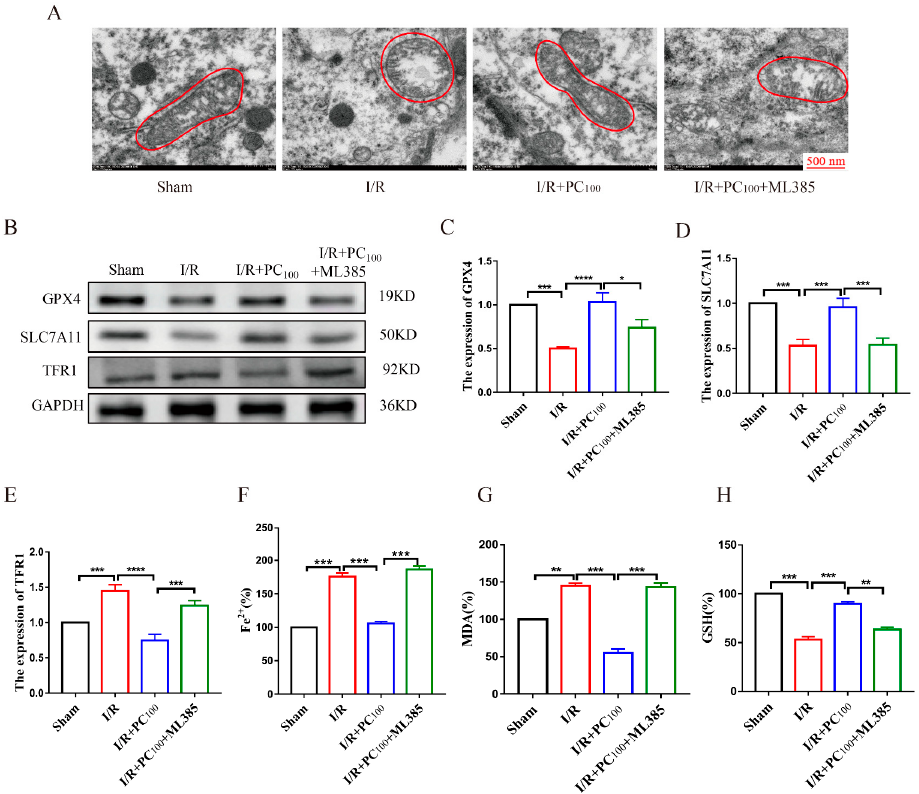
Figure 6. ML385 reversed the anti-ferroptotic effects of procyanidins in mice after CIRI. ( A ) Effect of ML385 on mitochondrial morphology in mice with CIRI. ( B − E ) Effect of ML385 on the expression of GPX4, SLC7A11, and TFR1 (n = 3). ( F , G ) Effect of ML385 on Fe 2+ and MDA in mice with CIRI (n = 3). ( H ) Level of GSH in the brain tissue of mice with CIRI (n = 3). All values are expressed as mean ± SD. n.s: no signi fi cant di ff erence, * p < 0.05, ** p < 0.01, *** p < 0.001, **** p < 0.0001.